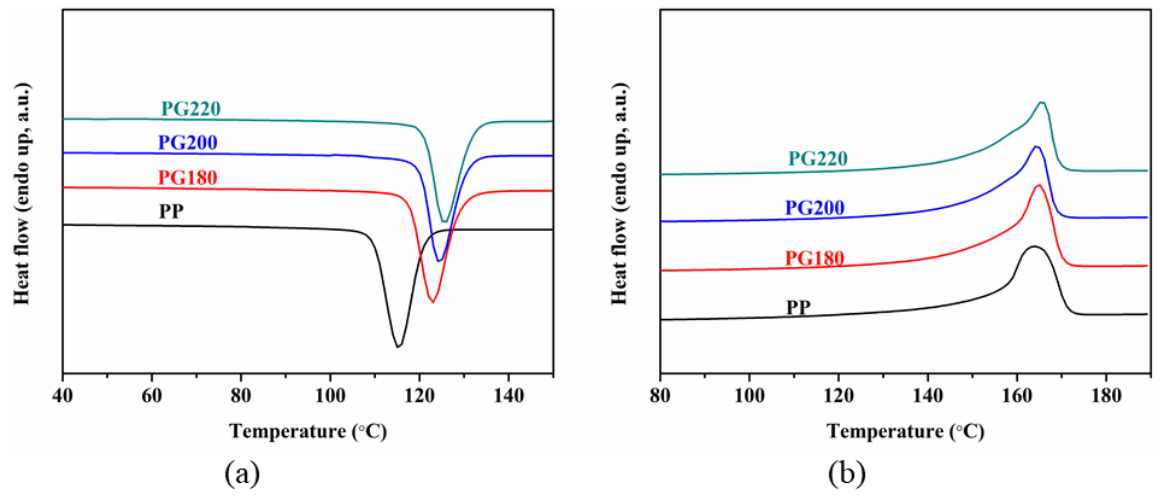
Figure 6. DSC ( a ) cooling and ( b ) heating curves for neat PP and PP/GIC composite samples.